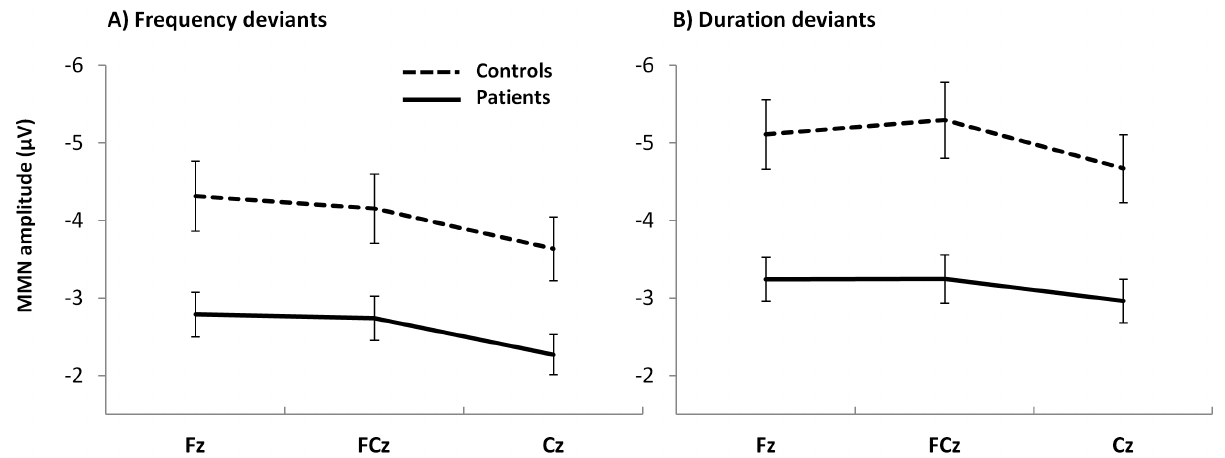
Figure 3. Diagrams of group means and standard errors. MMN amplitudes to frequency (A) and duration deviants (B) are presented for both groups at midline electrode